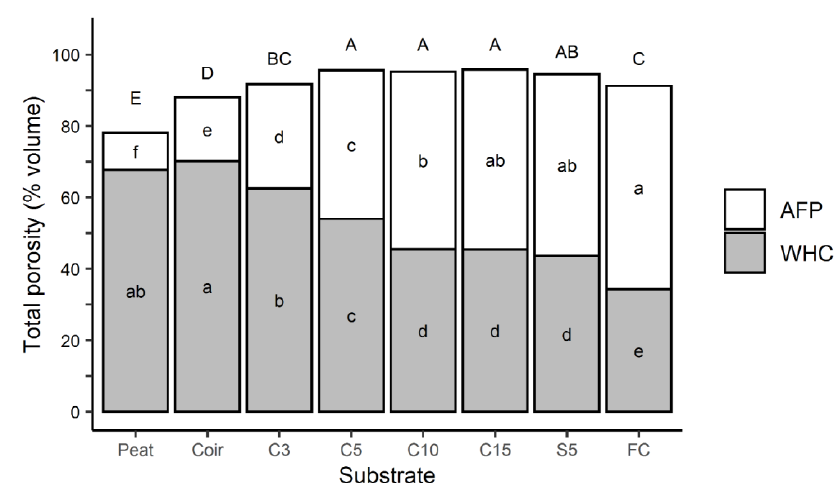
Figure 4. Porosity of peat, coir, and processed miscanthus substrates: water holding capacity (WHC), air-filled porosity (AFP), and total porosity (as the total height of stacked bars of WHC and AFP). Different lower case and capital letters indicate statistically significant differences in means among eight substrates at each substrate parameter WHC, AFP, and total porosity, respectively (Tukey’s HSD, p ≤ 0.05, n = 8). Miscanthus × giganteus was harvested with a forage harvester (FC, field-chips), then processed with a mechanical fraying facility through a 5-mm screen (S5, shreds) or a hammermill with screen sizes of 15, 10, 5, and 3 mm (C15, C10, C5, and C3, chips). Table 6. Hydration efficiency of peat, coir, and processed miscanthus